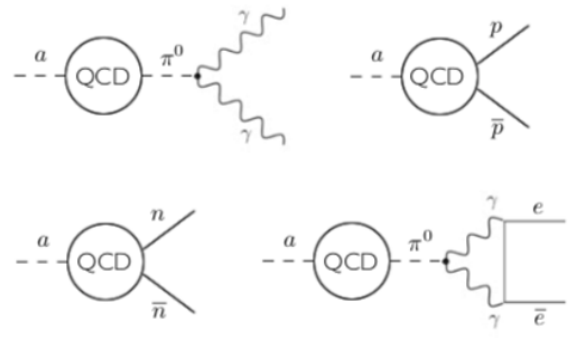
Figure 1. Model-independent axion couplings. The blob stands for non-perturbative QCD